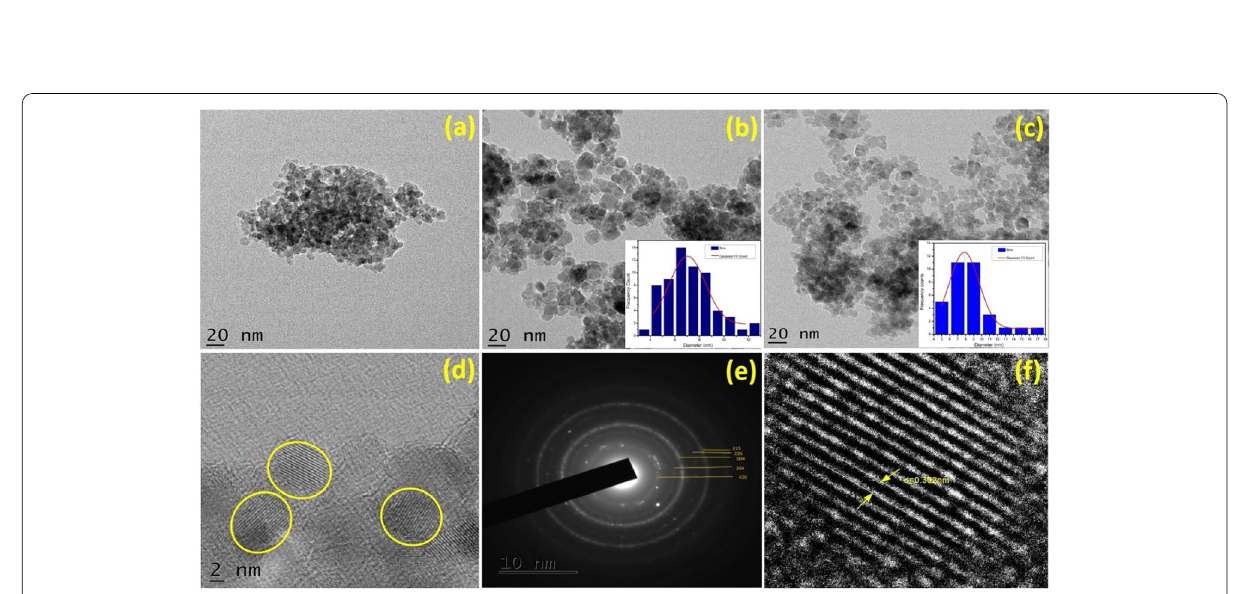
Fig. 3 XRD pattern of a undoped and Zn/Mg-co-doped TiO 2 (different wt%) b ZMT4 and ZMT4S2 (before and after calcinations). (BC-Before calcination, and AC-After calcination)